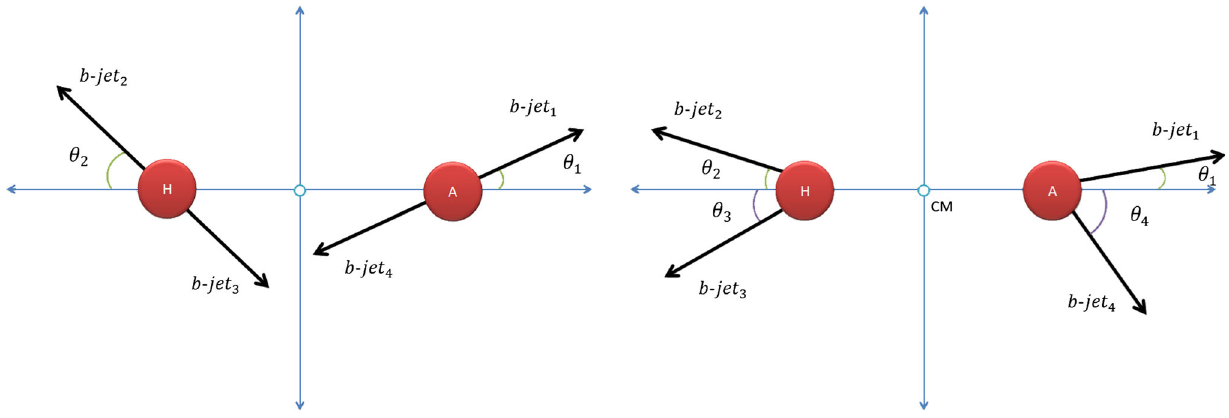
Fig. 3 Schematic view of a randomly selected event showing H and A decay to b ¯ b with each decay picture captured in the rest frame of the decaying particle ( a ) and in the laboratory frame ( b